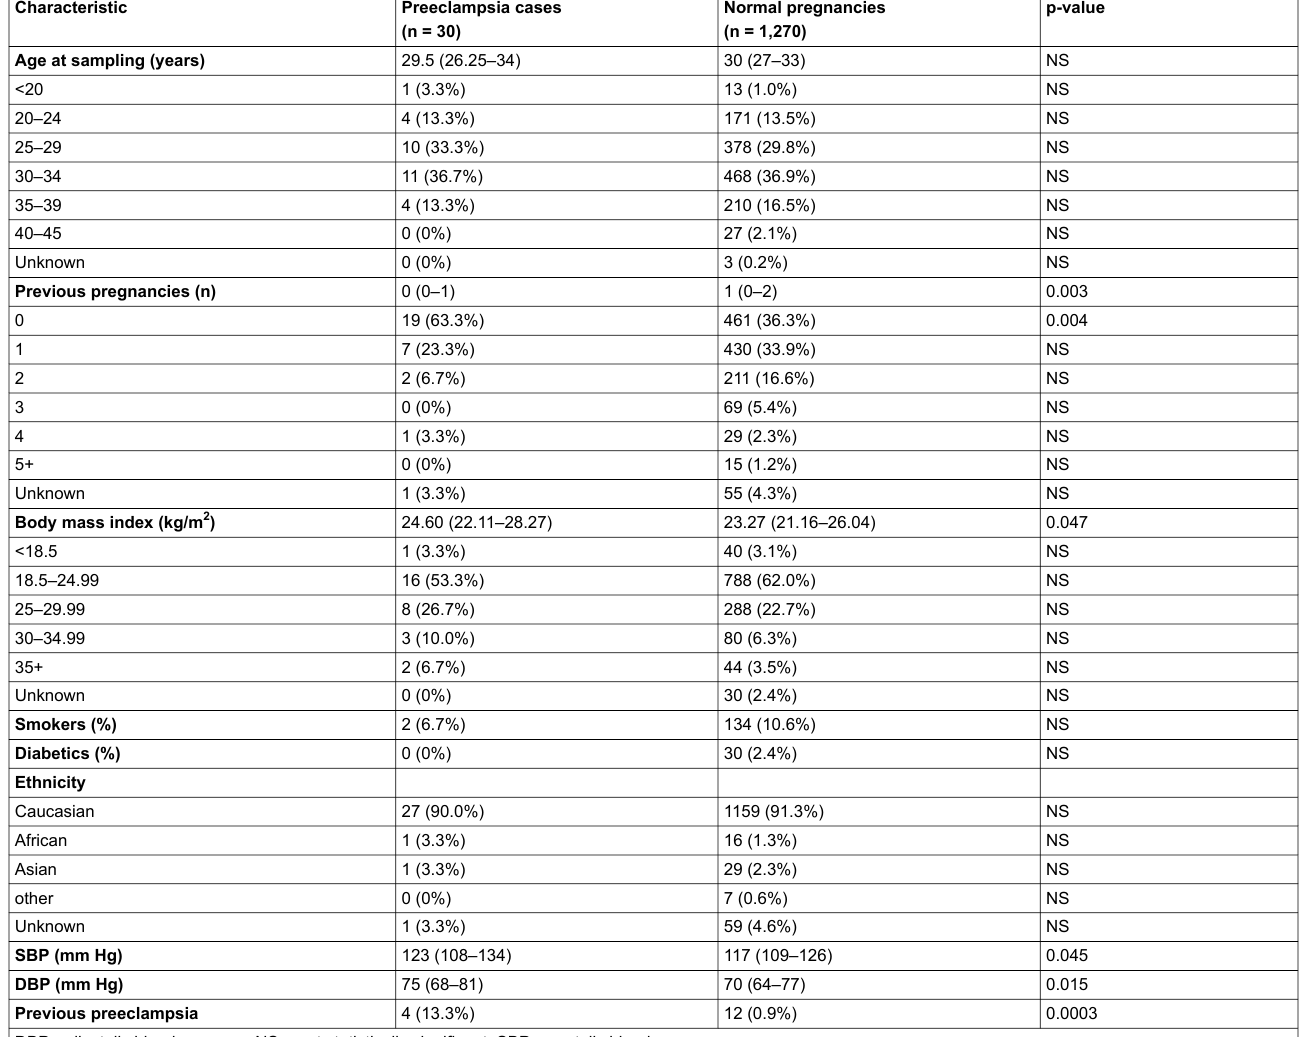
Table 2: Maternal characteristics presented as median (interquartile range) or number of pregnancies (percentage) in followed-up women with and without preeclampsia. Characteristics were obtained from pregnancies at gestational age 10+3 until 13+6 weeks.